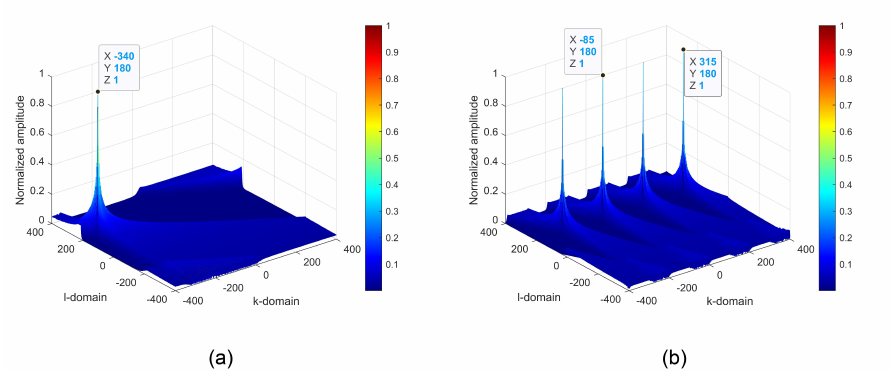
Figure 1. Simulation results of Example 1. ( a ) The result of MDCFT. ( b ) The result of ZDCFT ( α = 4, β =